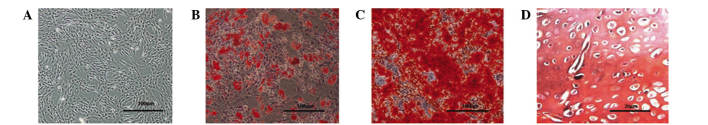
Characterization of MSCs. (A) The MSCs assumed a polymorphic, fibroblast-like morphology and were able to be differentiated into (B) adipocytes, following two weeks of culture in adipogenic medium (Oil red O staining), (C) osteoblasts, following three weeks of culture in osteogenic induction medium (Alizarin red staining) and (D) chondrocytes, following two weeks of culture in poly(lactic-co-glycolic acid) (Safranin O staining). The scale bars for A–C represent 100 µm, while the scale bar in D represents 20 µm. MSCs, mesenchymal stem cells.